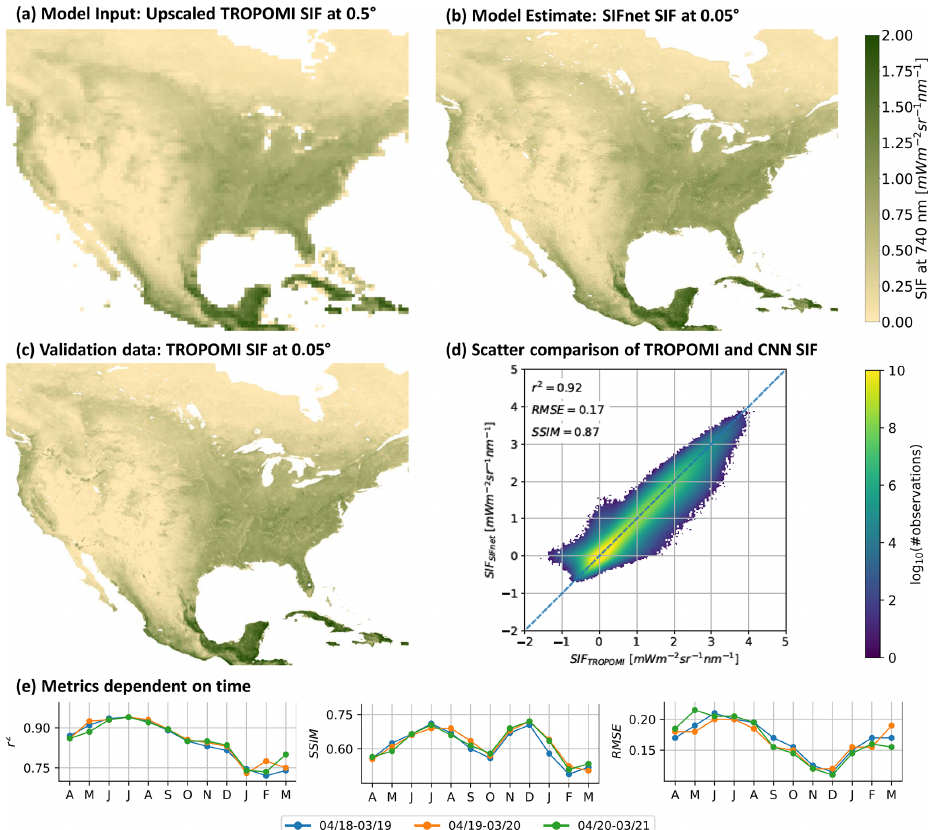
Figure 4. Test set results of CNN training at 0.05 ◦ . Panel (a) shows low-resolution SIF that is used as model input, (b) shows the estimated SIF at 0.05 ◦ by SIFnet, (c) shows the measured TROPOMI SIF at 0.05 ◦ from Köhler et al. (2018), (d) shows the scatter comparison between TROPOMI SIF and the SIFnet estimate at 0.05 ◦ , and (e) shows for each investigated month the metrics r 2 , SSIM, and RMSE. Metrics are calculated at 16d resolution and averaged to monthly values afterwards.